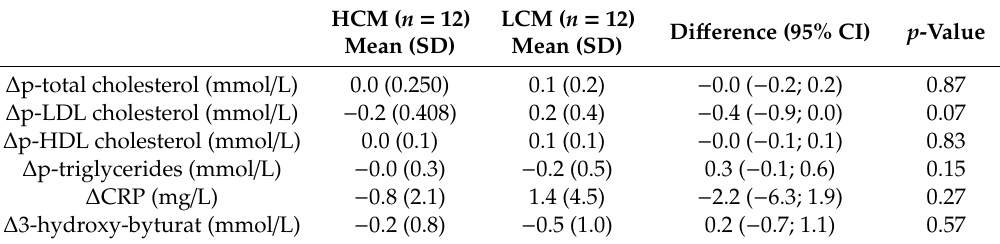
Table 5. E ff ect on tertiary outcomes.